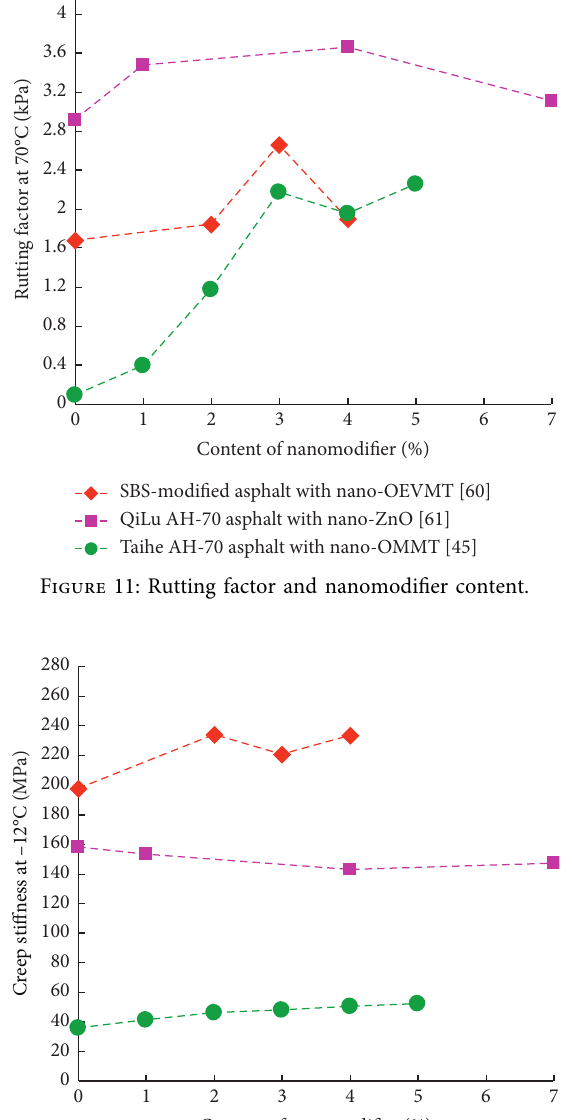
Figure 10: Ductility and nanomodifier content.